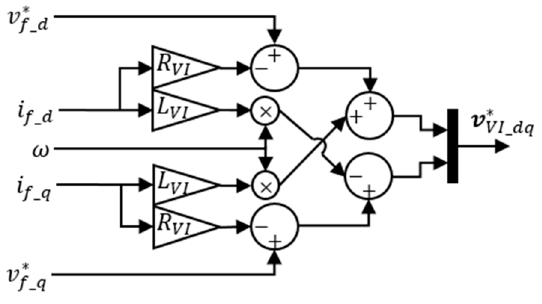
Figure 5. Virtual impedance.